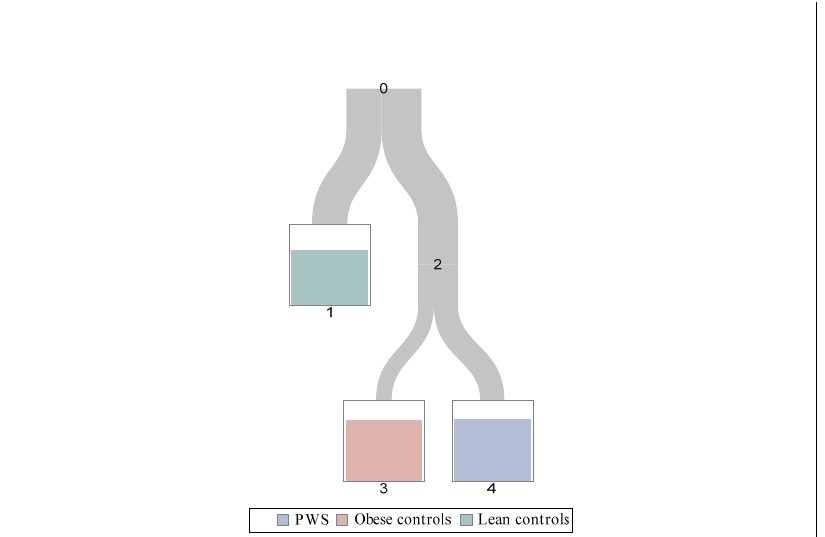
Figure 5. Classification tree according to fasting peptide concentrations. 0 All participants, 1 mostly leans controls, 2 mostly obese and Prader-Willi (PWS) subjects, 3 mostly obese subjects, 4 mostly PWS subjects.